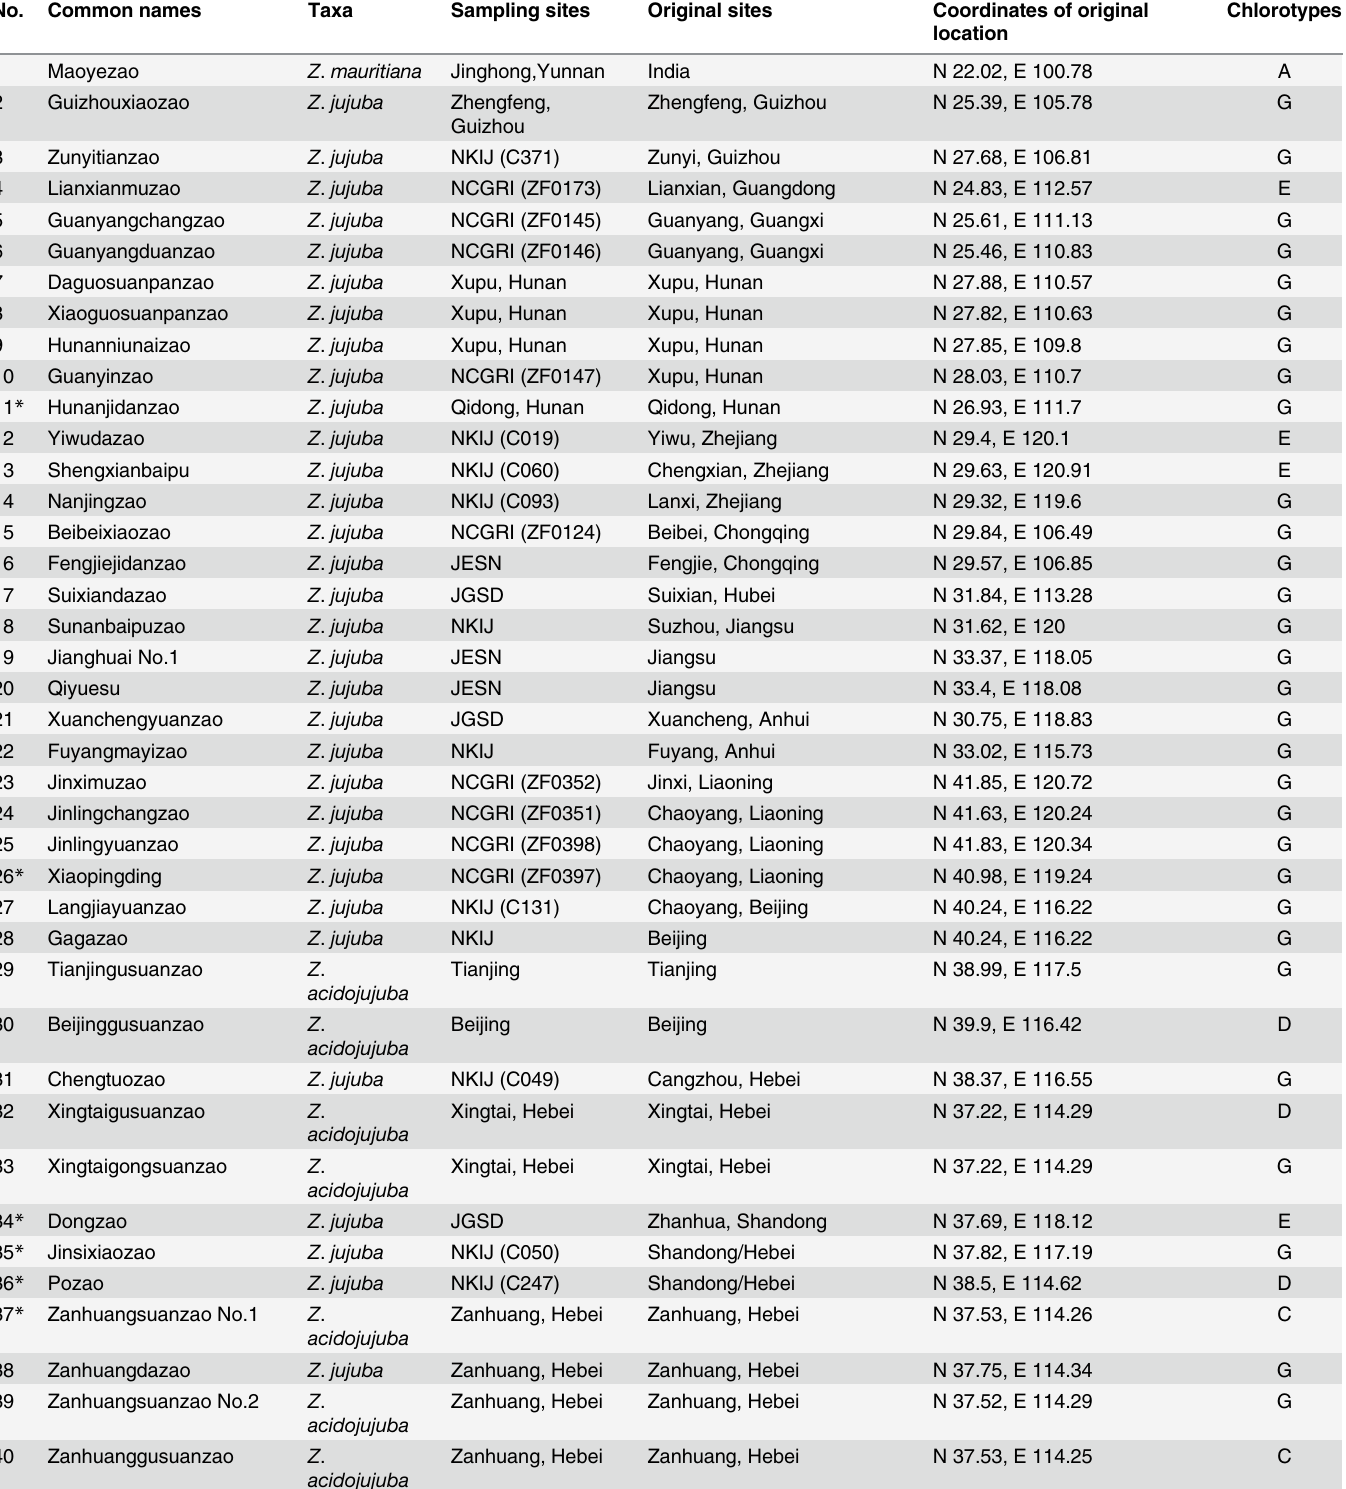
Table 1. Jujube cultivars and wild jujube individuals used in the characterization of the cpSSR markers. No. Common